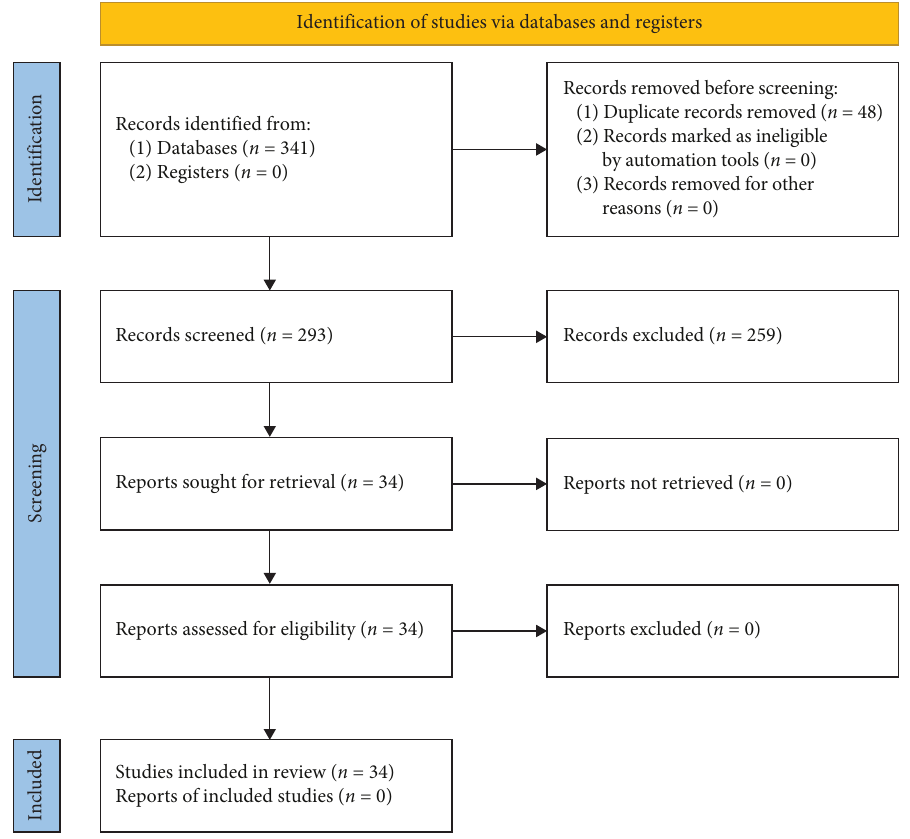
F IGURE 1: Flowchart of the literature